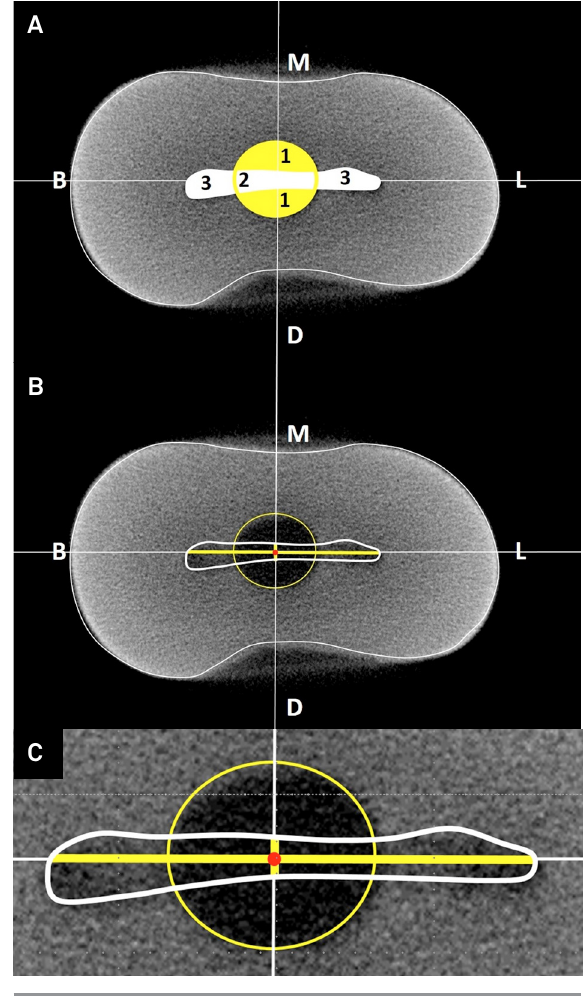
Figure 2. Post-instrumentation cross-sections of the cervical third. A - Areas of the root canal: (1) instrumentation outside canal limits, (2) instrumentation inside canal limits, and (3) non-instrumented. B - Distances (yellow lines) from the center position of files (red dot) to the limit of the original root canal (white line) in the buccolingual and mesiodistal directions. C - Magnification of the previous image showing the limits of the original root canal before instrumentation (white perimeter), the action area of files (yellow perimeter), and the buccolingual and mesiodistal lines used for the measurements (yellow